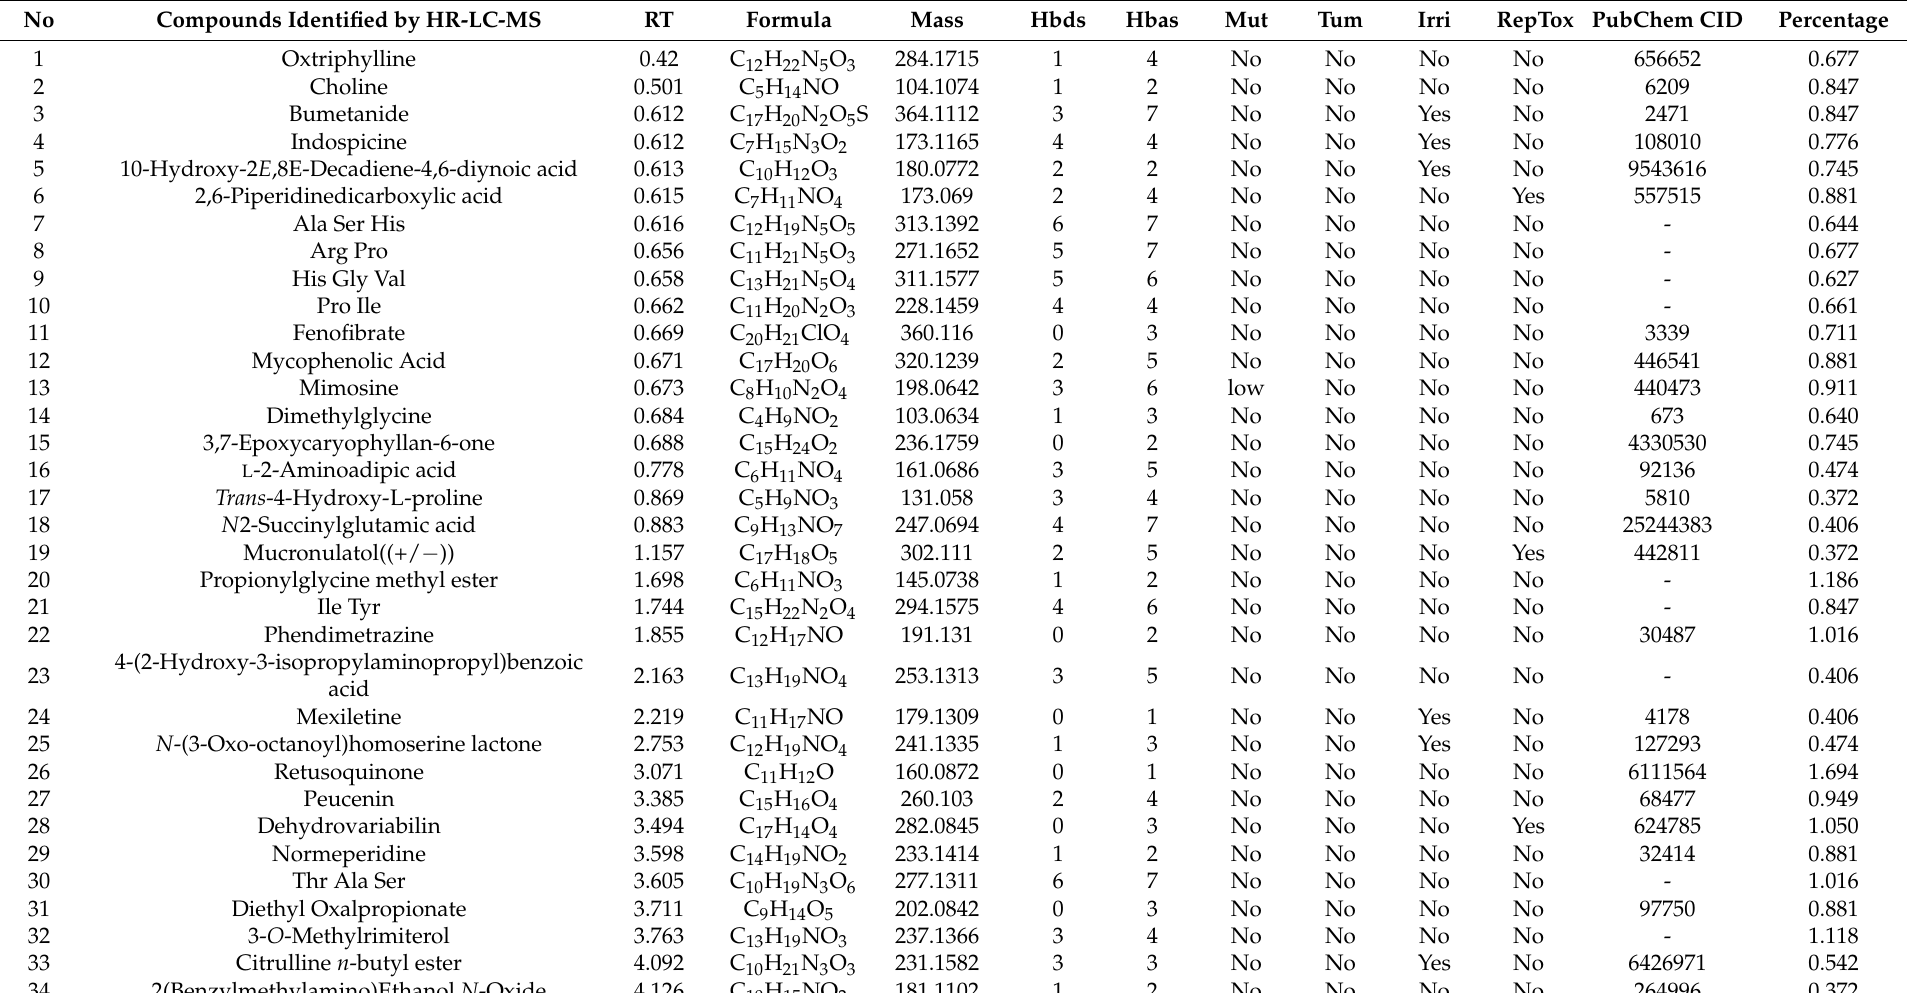
Table 1. Phytochemical profile of AIRME using chromatography techniques (HR-LC-MS and GC-MS), antioxidant descriptors (Hbds—Hydrogen bond donor count and Hbas—Hydrogen